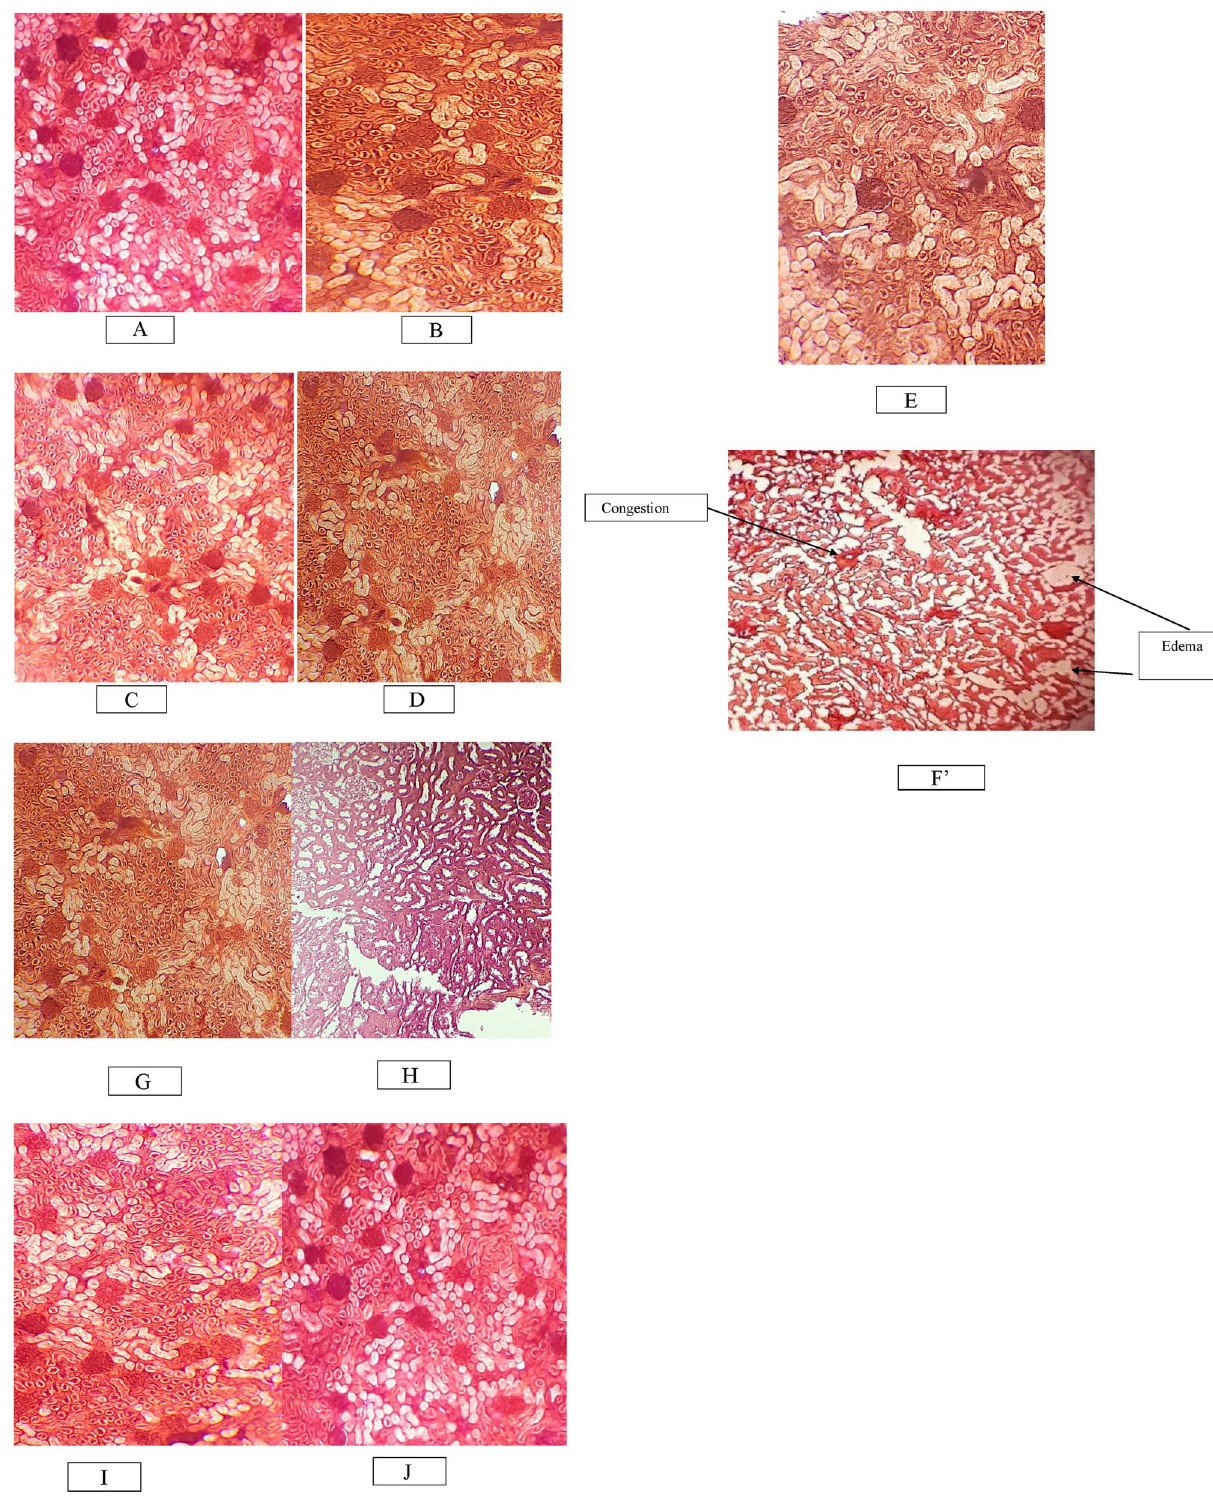
Figure 2. Histopathological examination of kidney slides of different treatment groups seen under a microscope at 10 × 10X magnification. ( A ) Control group; ( B ) Cystone treated group; ( C ) Bee pollen treated group 100 mg; ( D ) Bee pollen treated group 250 mg; ( E ) Bee pollen treated group 500 mg; ( F ) EG treated group; ( G ) EG + Cystone treated group; ( H ): EG + Bee pollen treated group 100 mg; ( I ) EG + Bee pollen treated group 250 mg; ( J ) EG + Bee pollen treated 500